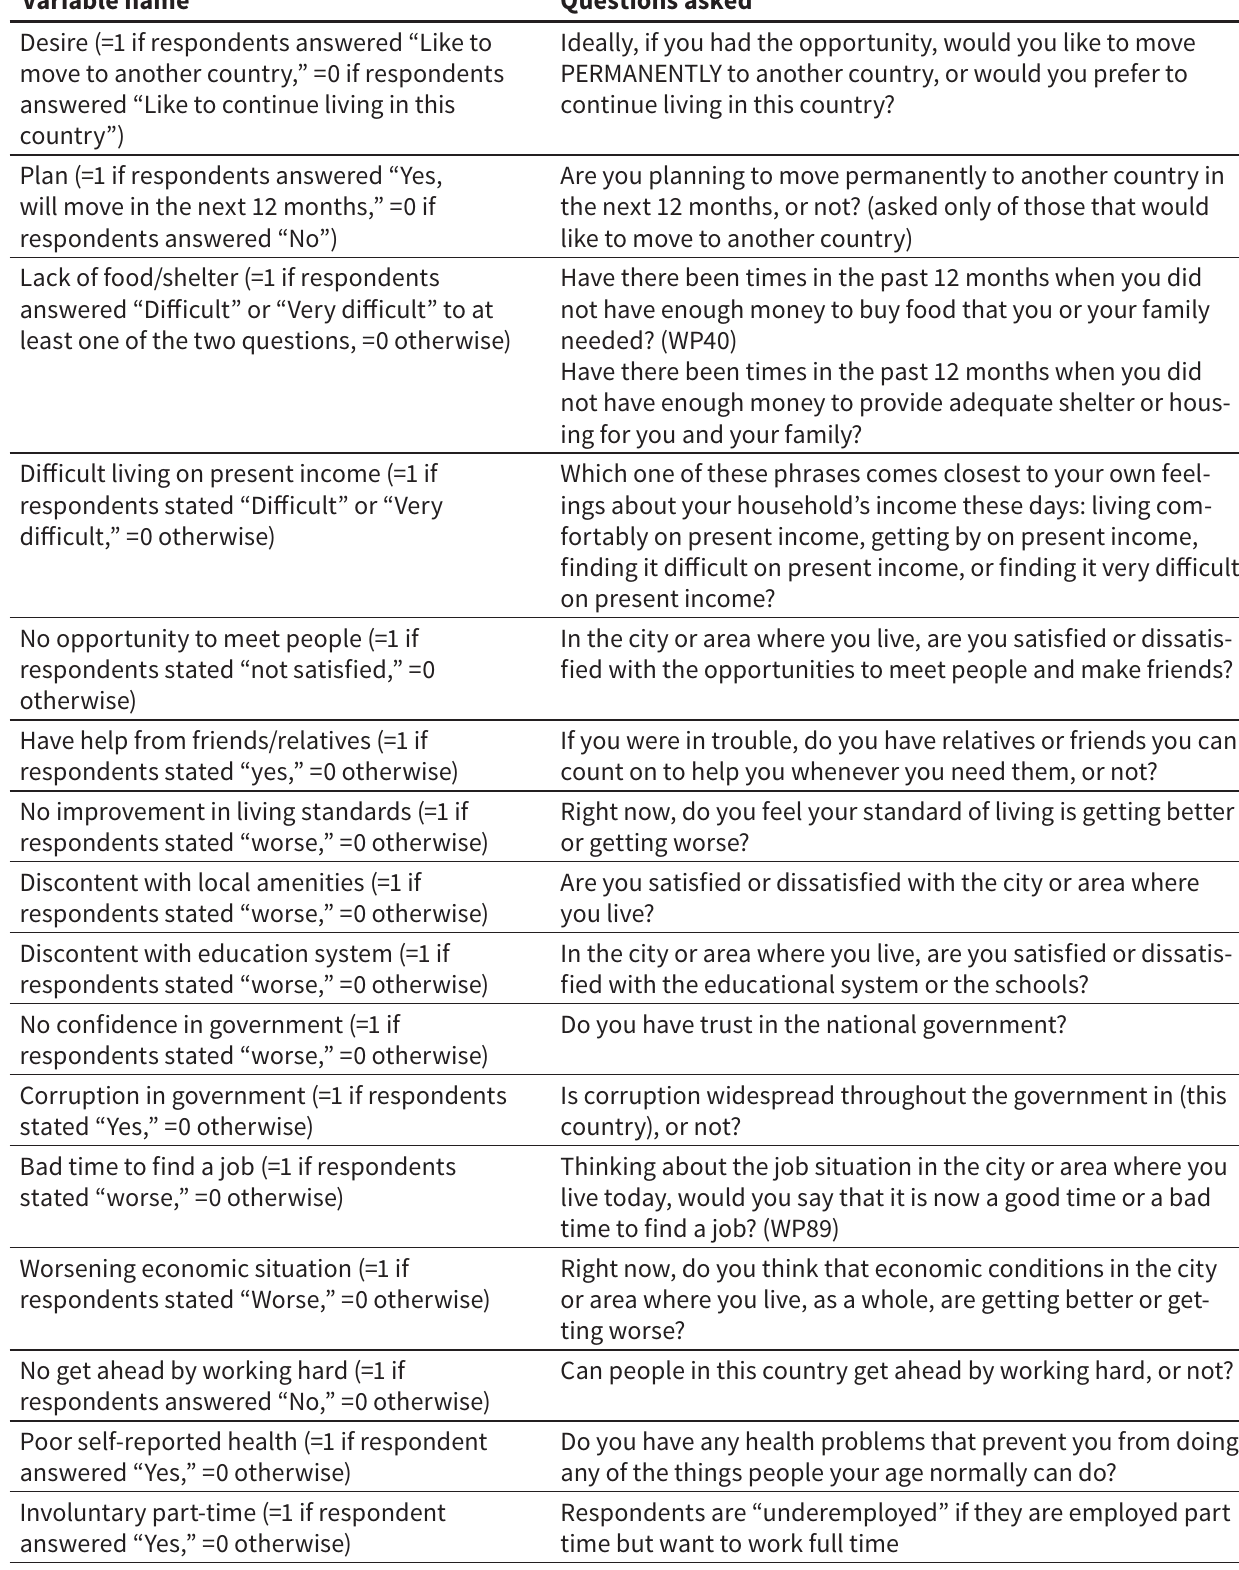
Description of GWP questions underlying main explanatory